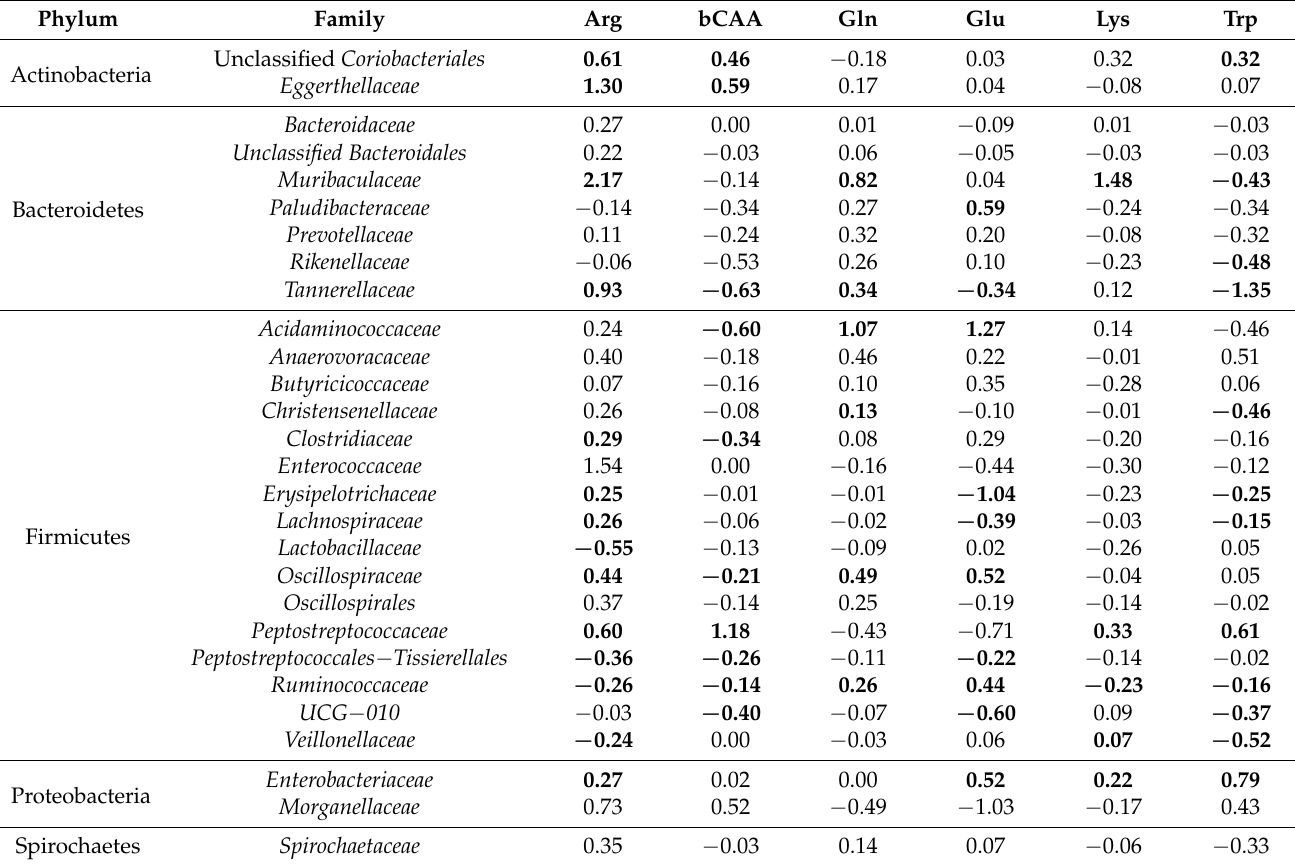
Table 1. Effect of amino acids on microbial composition (family level; absolute values, estimated upon multiplying proportions (%) based on 16S rRNA gene profiling with total cell counts) at the end of the 48 h incubation with a porcine colonic microbiota ( n = 3). The data is presented as the average difference between the log 10 -transformed absolute abundance (log(cells/mL)) in a treatment versus the corresponding untreated blank incubation. A value below zero indicates a decrease upon treatment, while a value above zero, indicates that this family is stimulated by a given amino acid. Statistically significant differences as compared to this blank are indicated in bold ( p <